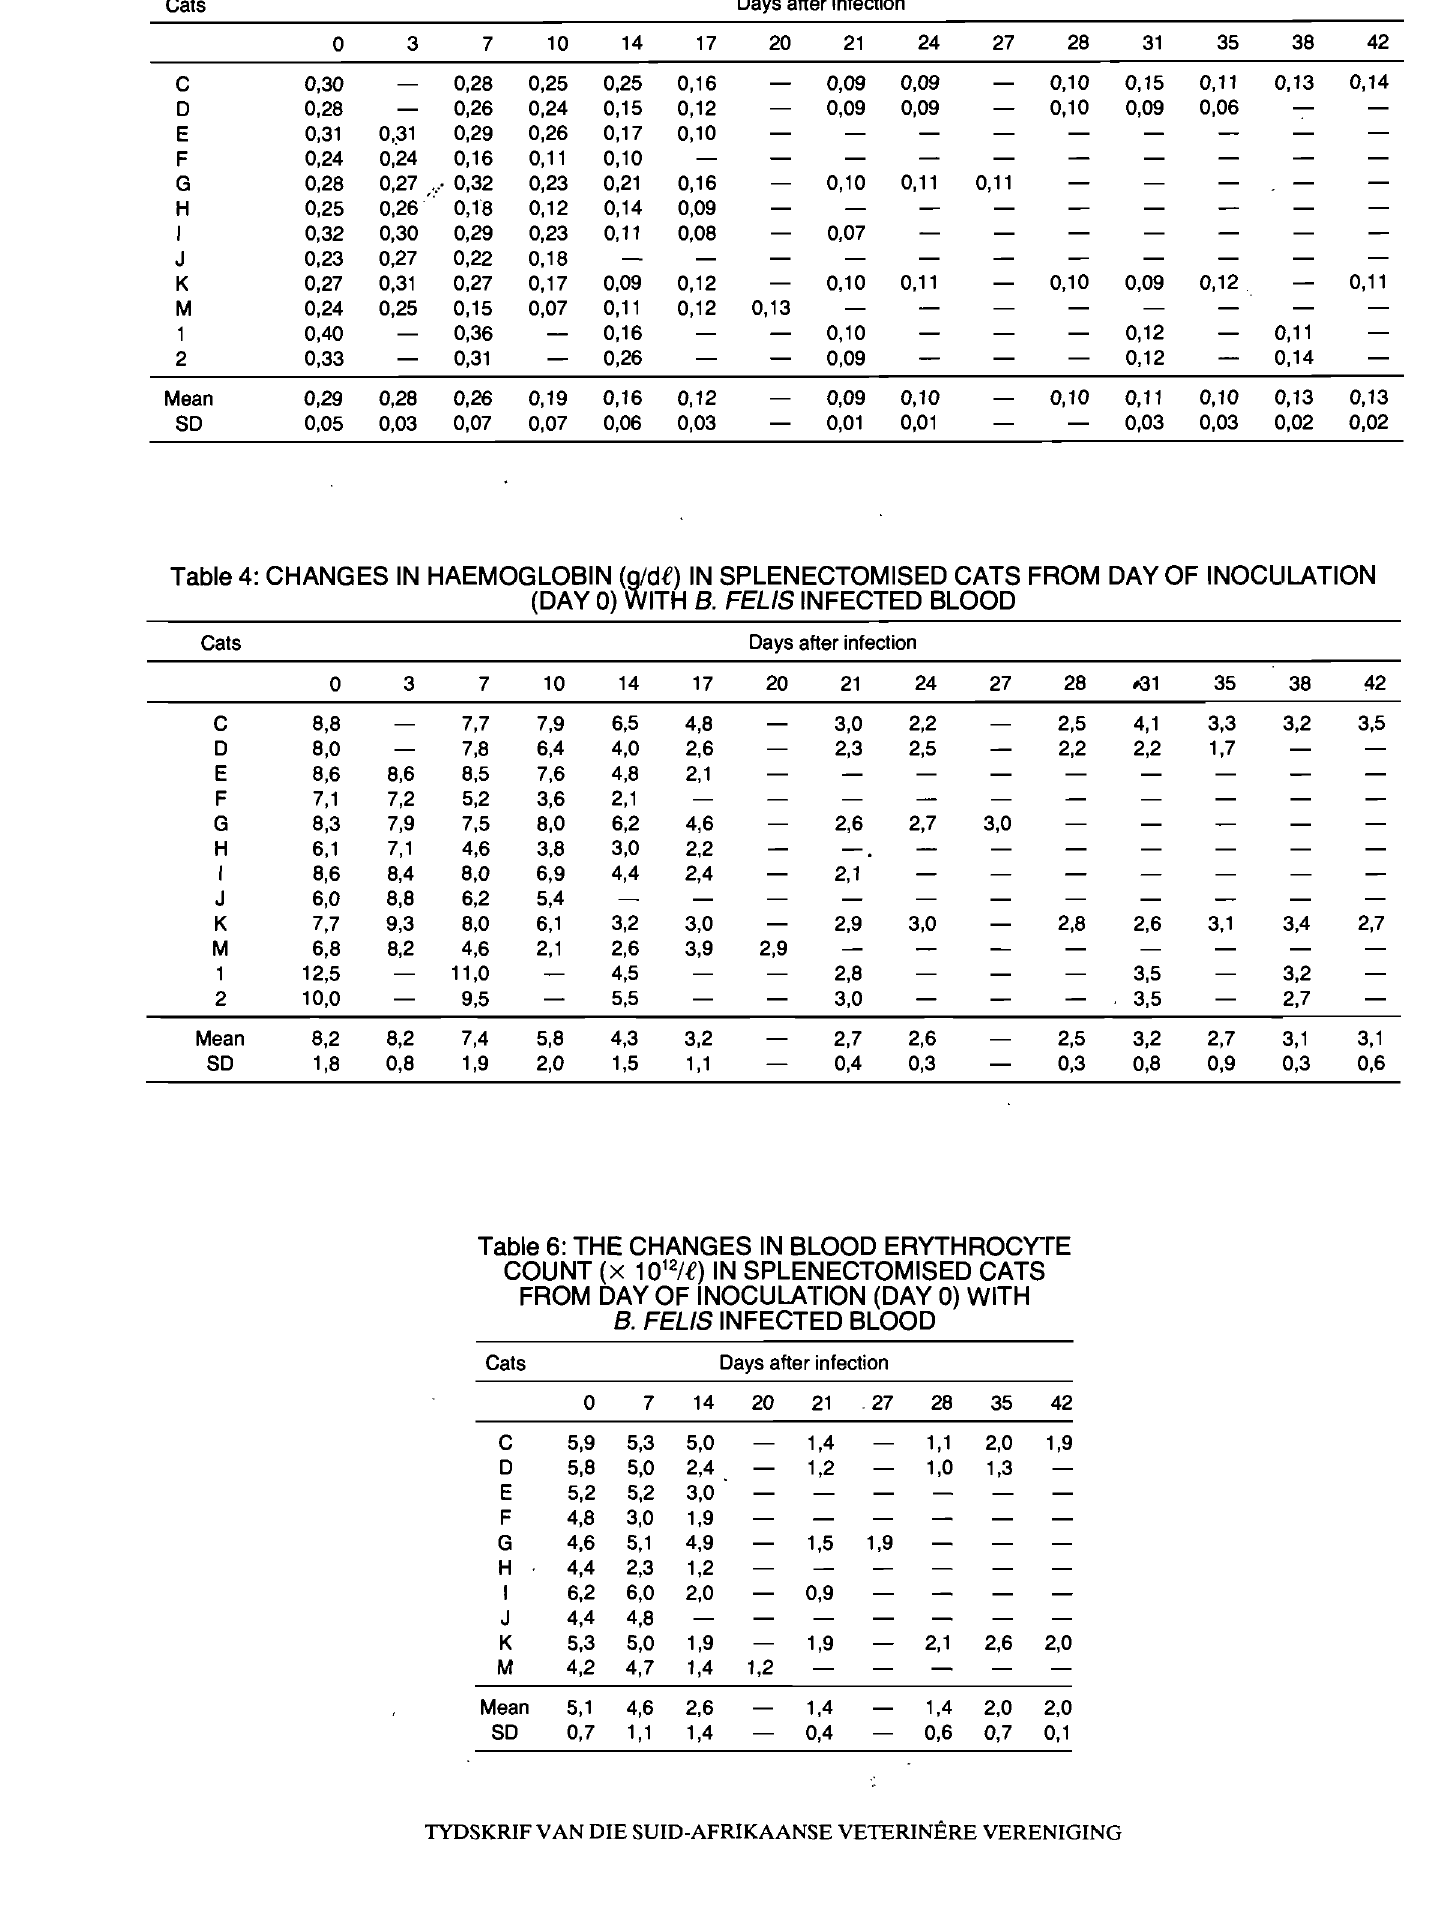
Table 2: THE CHANGES IN HAEMATOCRIT IN SPLENECTOMISED CATS FROM DAY OF INOCULATION (DAY 0) WITH B. FELIS INFECTED BLOOD